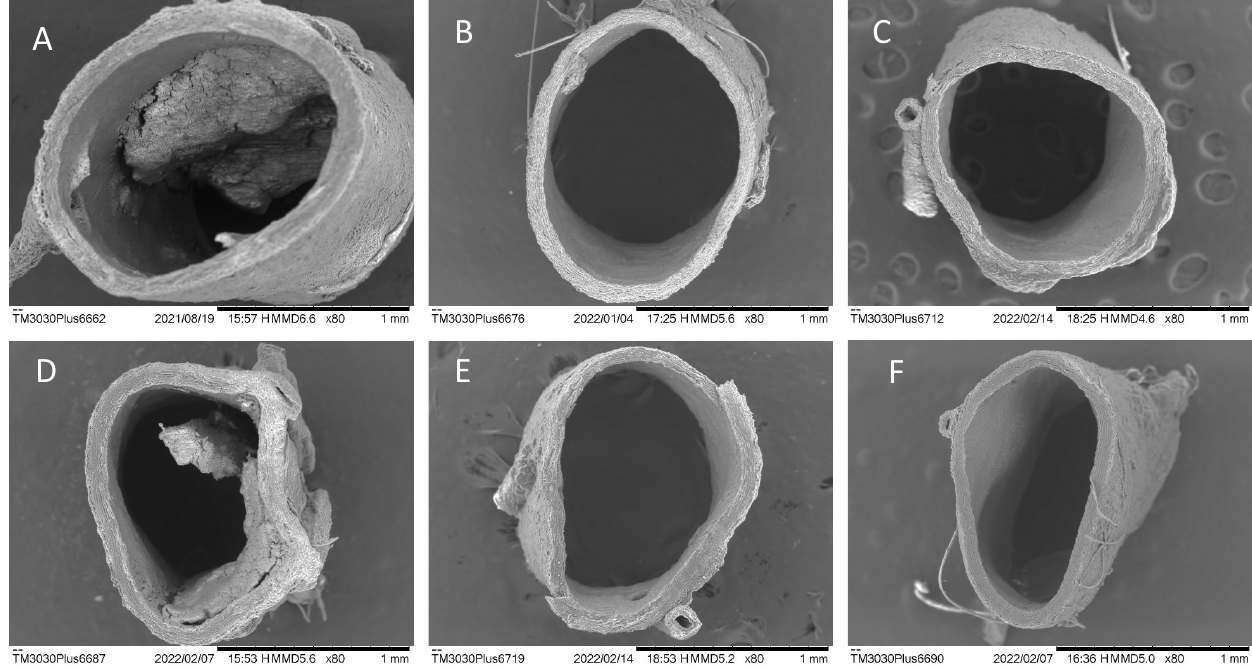
Figure 3. Representative SEM photomicrographs of the thoracic aorta cross-sections. ( A ) Negative control receiving only distilled water. ( B ) Treated with Ormona SI ® at 200 mg/kg/day. ( C ) Treated with Ormona RC ® at 200 mg/kg/day. ( D ) Treated with soybean germ only at 200 mg/kg/day. ( E ) Treated with Ormona RC ® (200 mg/kg/day) plus simvastatin (20 mg/kg/day). ( F ) Positive control, treated with simvastatin at 20 mg/kg/day.